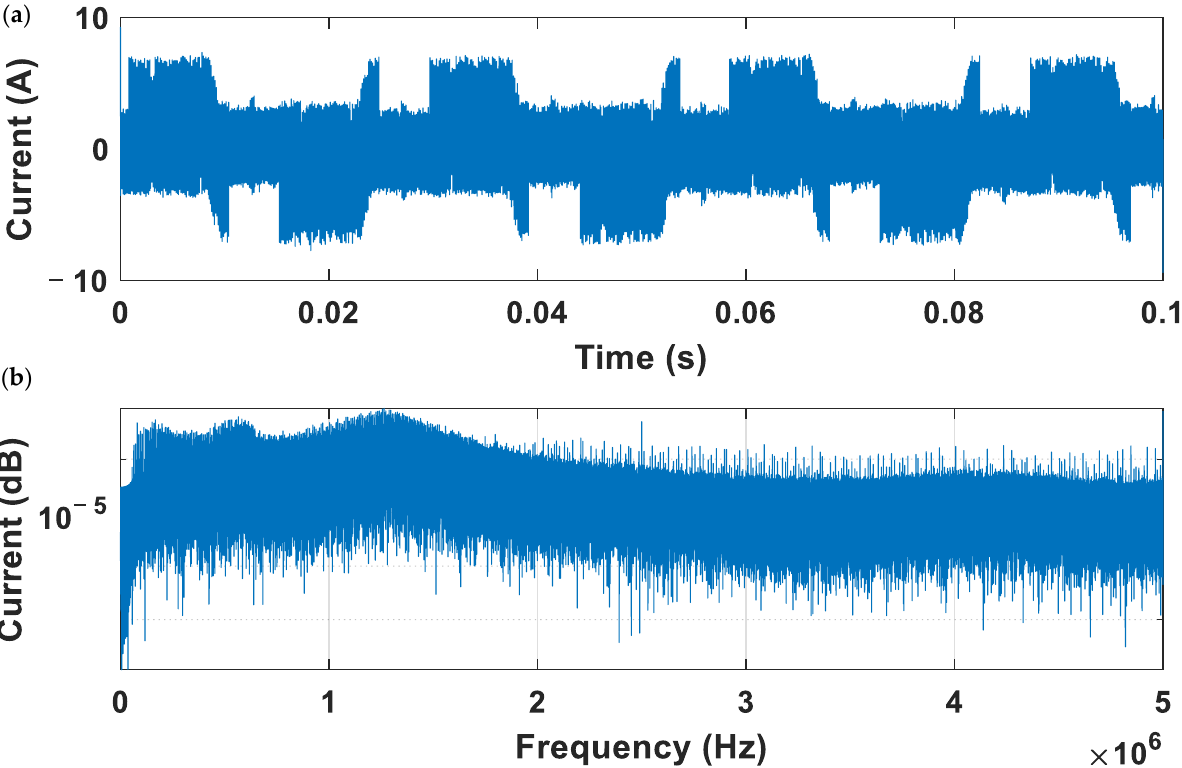
Figure 9. Decomposed signal above 9 kHz. ( a ) Time-domain signal, ( b ) Fourier transform of the signal.